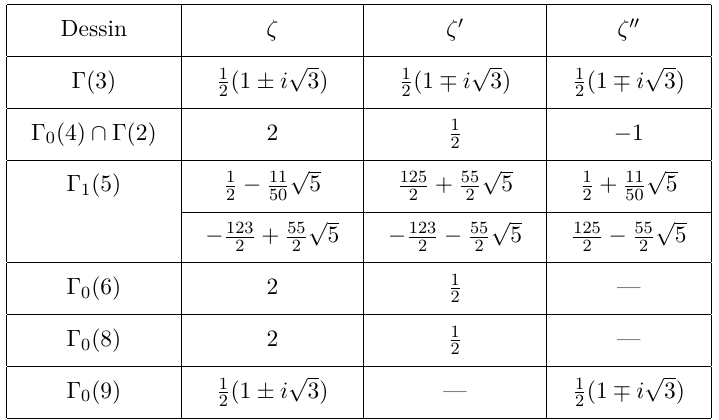
Table 9. The parametrizations for each case are related by triality. The hyphens indicate that such ζ either gives no solution to mass parameters ( Γ formations of masses ( Γ (9) 0